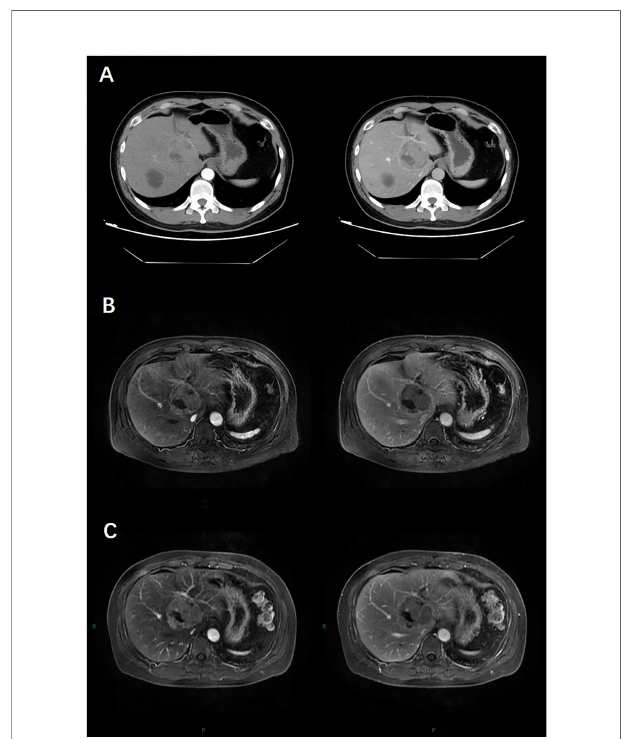
FIGURE 1 | At baseline (May 2019), contrast-enhanced CT (A) and MRI (B) indicated a 5.5-cm lesion in the liver with obvious enhancement on arterial phase images and washout on delayed images. After four cycles of chemotherapy (July 2019), contrast-enhanced MR (C) indicated stable disease